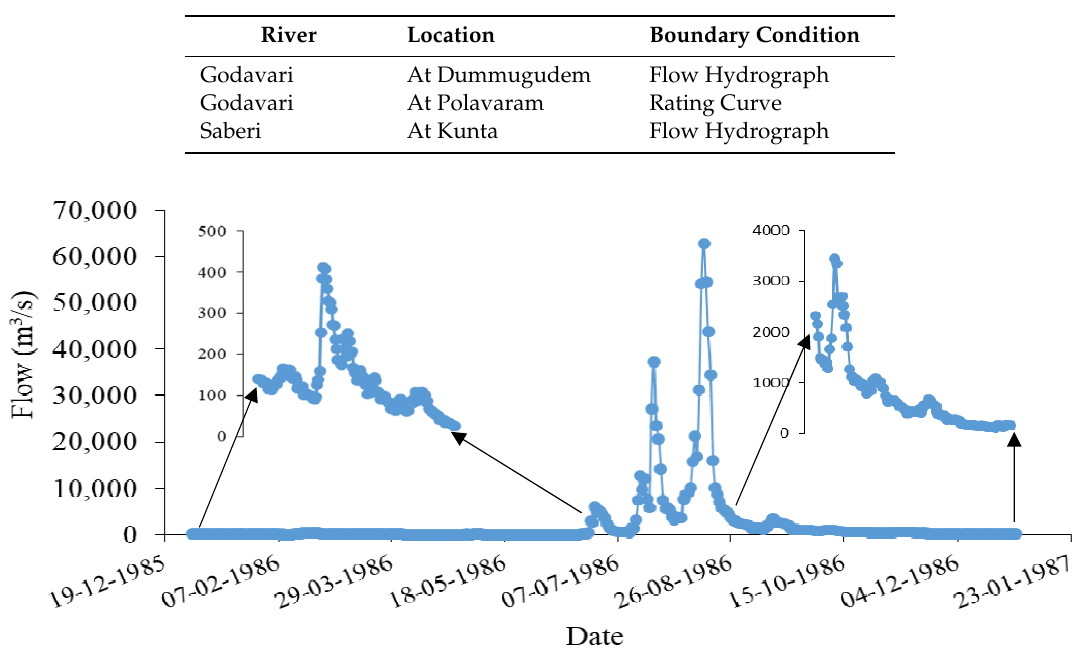
Figure 5. Flow hydrograph data considered for upstream boundary condition at Dummugudem for the year